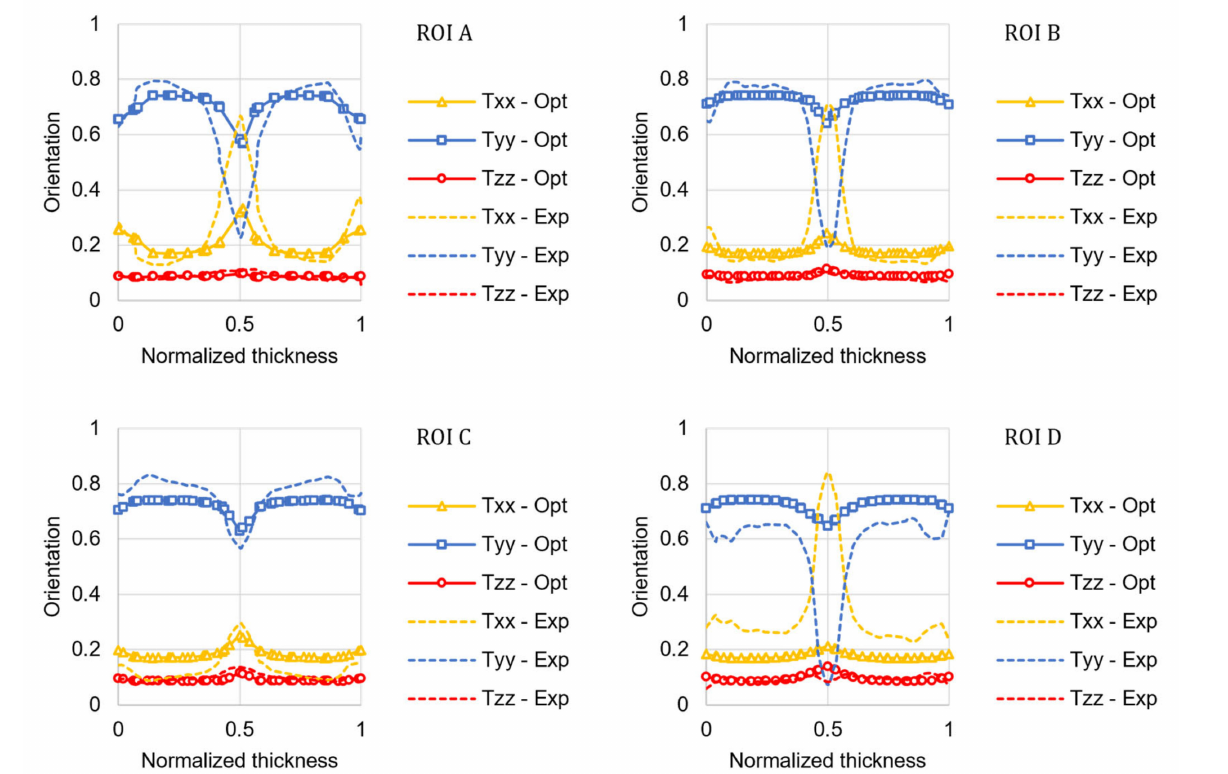
Figure 7. Comparison between the µ CT experimental results (Exp) of the fiber orientation tensor principal components and the numerical results predicted using the optimized coefficients (Opt) of the RSC model for the four ROIs in the